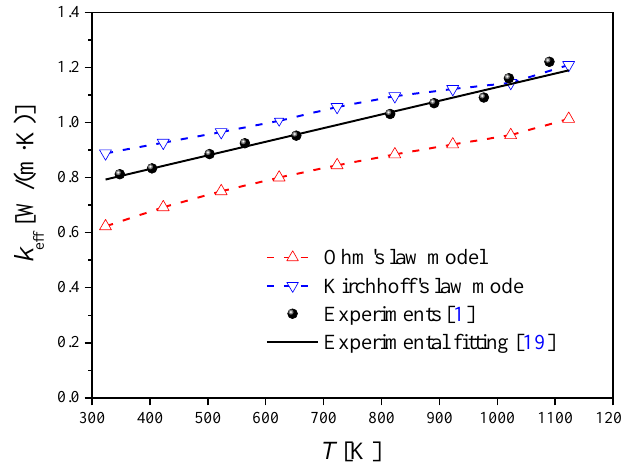
Figure 8. The e ff ective thermal conductivities of random packings calculated with thermal resistance Figure 8. The effective thermal conductivities of random packings calculated with thermal network of Ohm’s law model and Kirchho ff ’s law resistance network of Ohm’s law model and Kirchhoff’s law model.